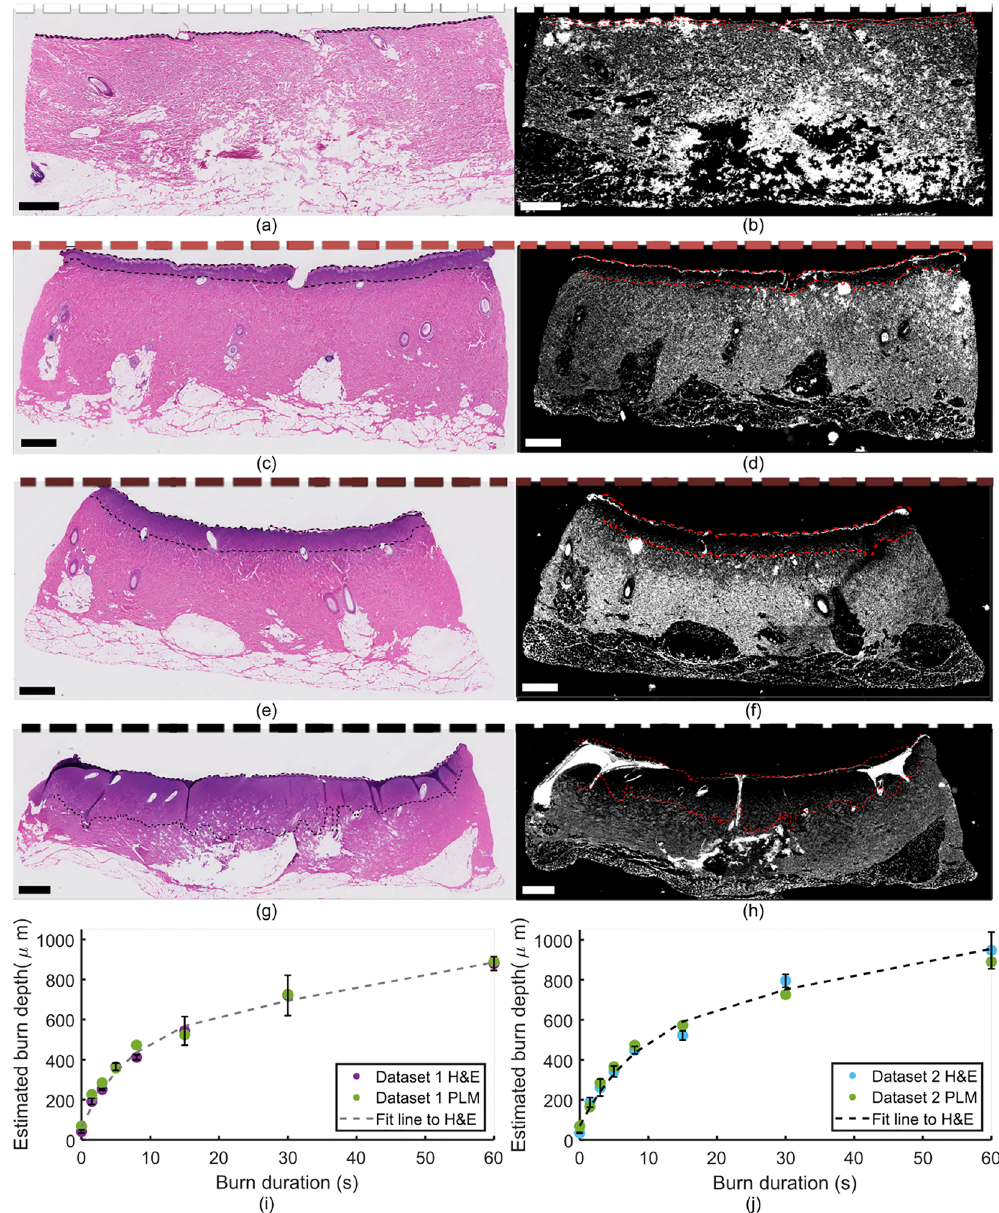
Figure 3. Zones of gelatinization identified with H&E histology for healthy tissue ( a ), and 5s ( c ), 15s ( e ), and 60s ( g ) burns, and corresponding PLM data ( b , d , f , h ). Dashed lines in black ( a , c , e , g ) and red ( b , d , f , h ) show automatically-extracted surface and injury boundaries. Summary of results for Datasets 1 ( i ) and 2 ( j ) show good agreement between H&E and PLM data. Error bars represent standard deviation across N = 6 histological cross sections for each Dataset. Scale bars = 1